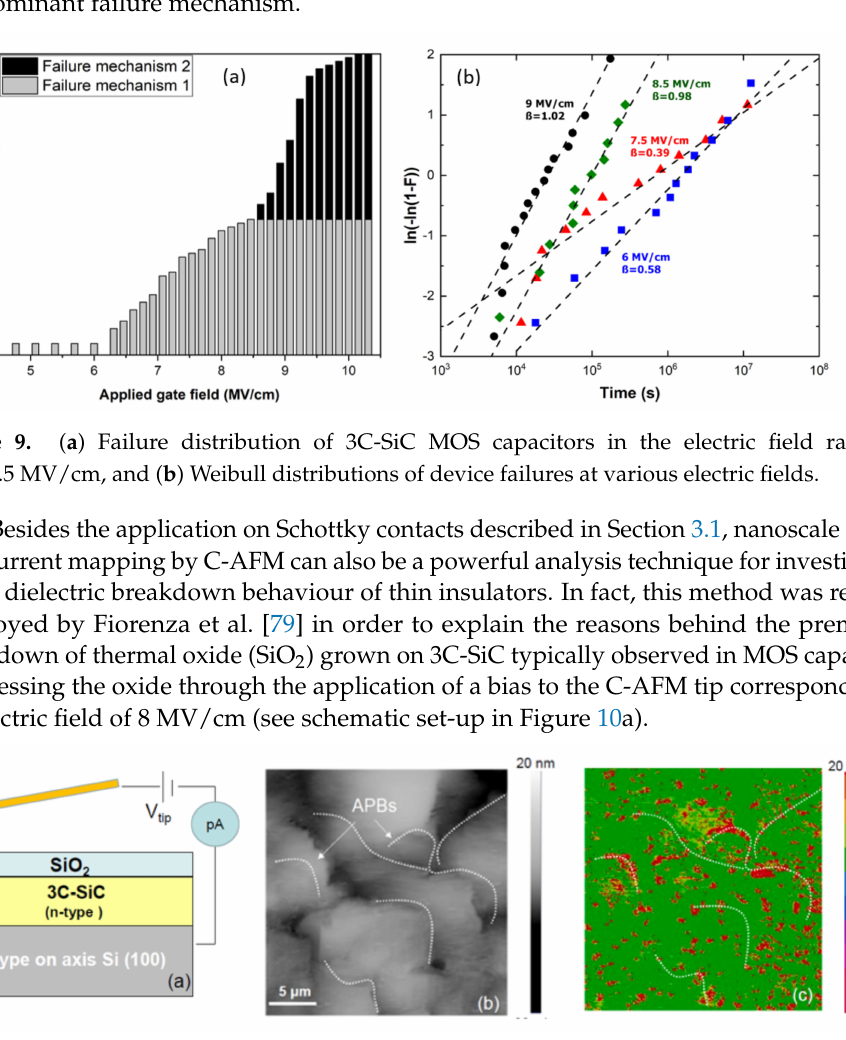
Figure 10. ( a ) C-AFM set-up adopted for the electrical characterization of the SiO 2 /3C-SiC system; ( b ) AFM morphology and ( c ) C-AFM current map acquired under the application of an electric field of 8 MV/cm to the tip. Adapted with permission from ref. [79]. Copyright © 2021 Elsevier